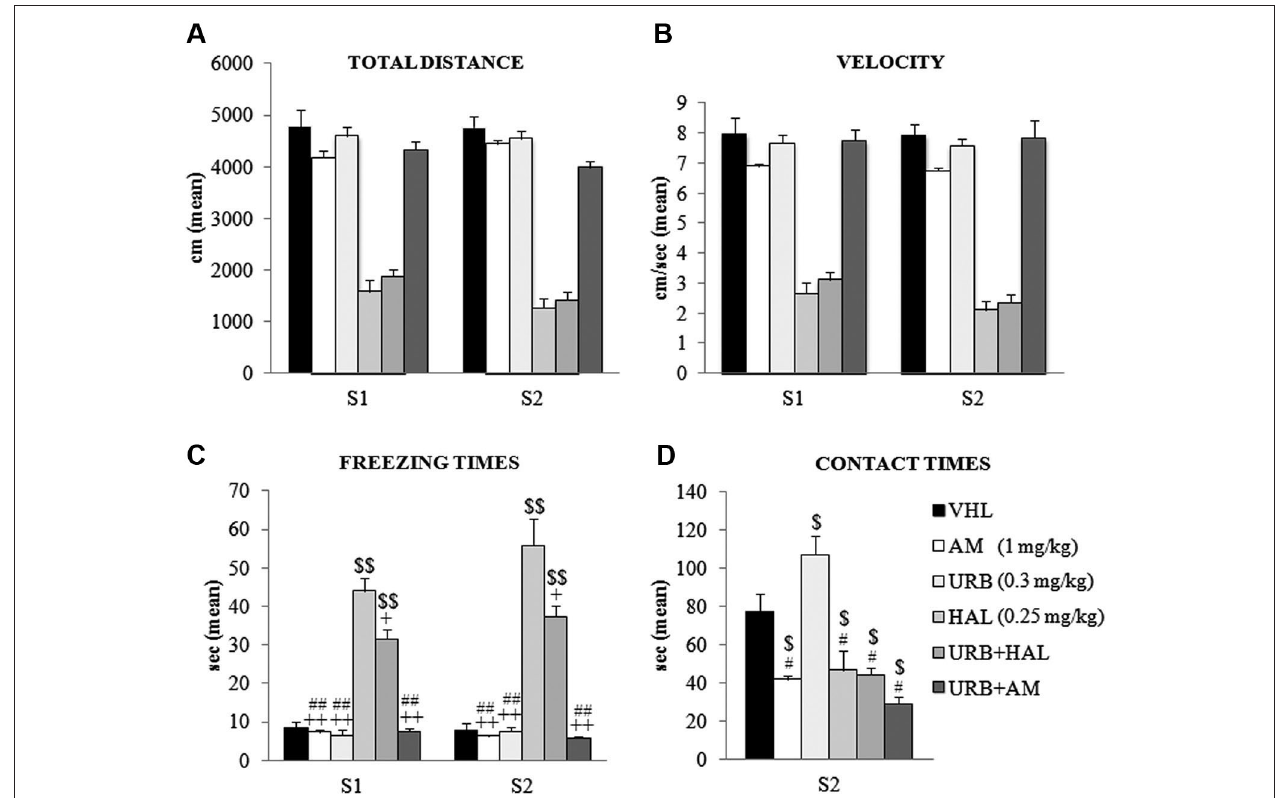
+; vs. VHL group p = 0.001, $$). The URB+HAL group had freezing times higher than URB, AM, URB+AM ( p = 0.001, ##) and VHL ( p = 0.001, $$) groups. In (D) , the URB group displayed the highest contact times ( vs. URB+HAL, URB+AM, HAL, AM groups at least p = 0.01, #; vs. VHL group p = 0.05, $). All groups exhibited contact times significantly (at least p = 0.04, $) lower than the VHL